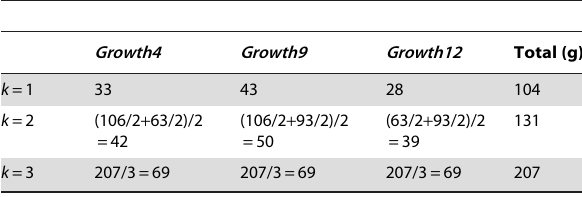
Table 3. Differences in total effects of the three loci Growth4 , Growth9.1 , and Growth 12 based on their